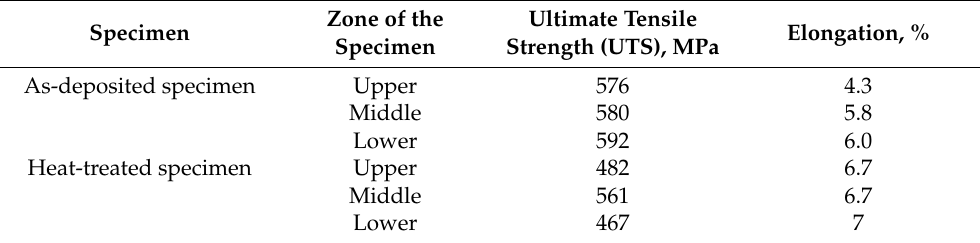
Zone of the Ultimate Tensile Elongation, % Specimen Specimen Strength (UTS), MPa As-deposited specimen Upper 576 4.3 Middle 580 5.8 Lower 592 6.0 Heat-treated specimen Upper 482 6.7 Middle 561 6.7 Lower 467